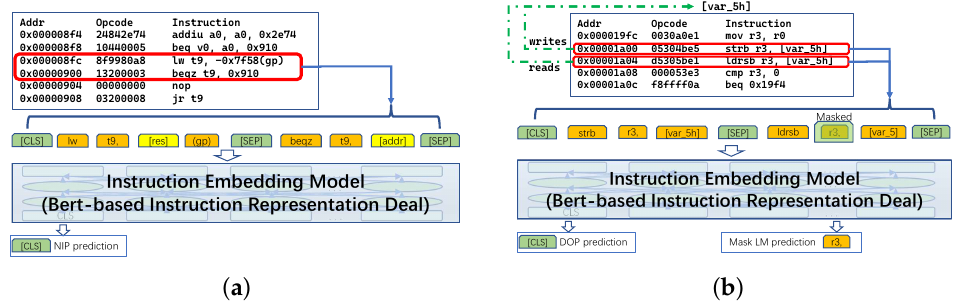
Figure 3. Instruction embedding model. ( a ) Next Instruction Prediction (NIP); ( b ) Instruction Order Prediction